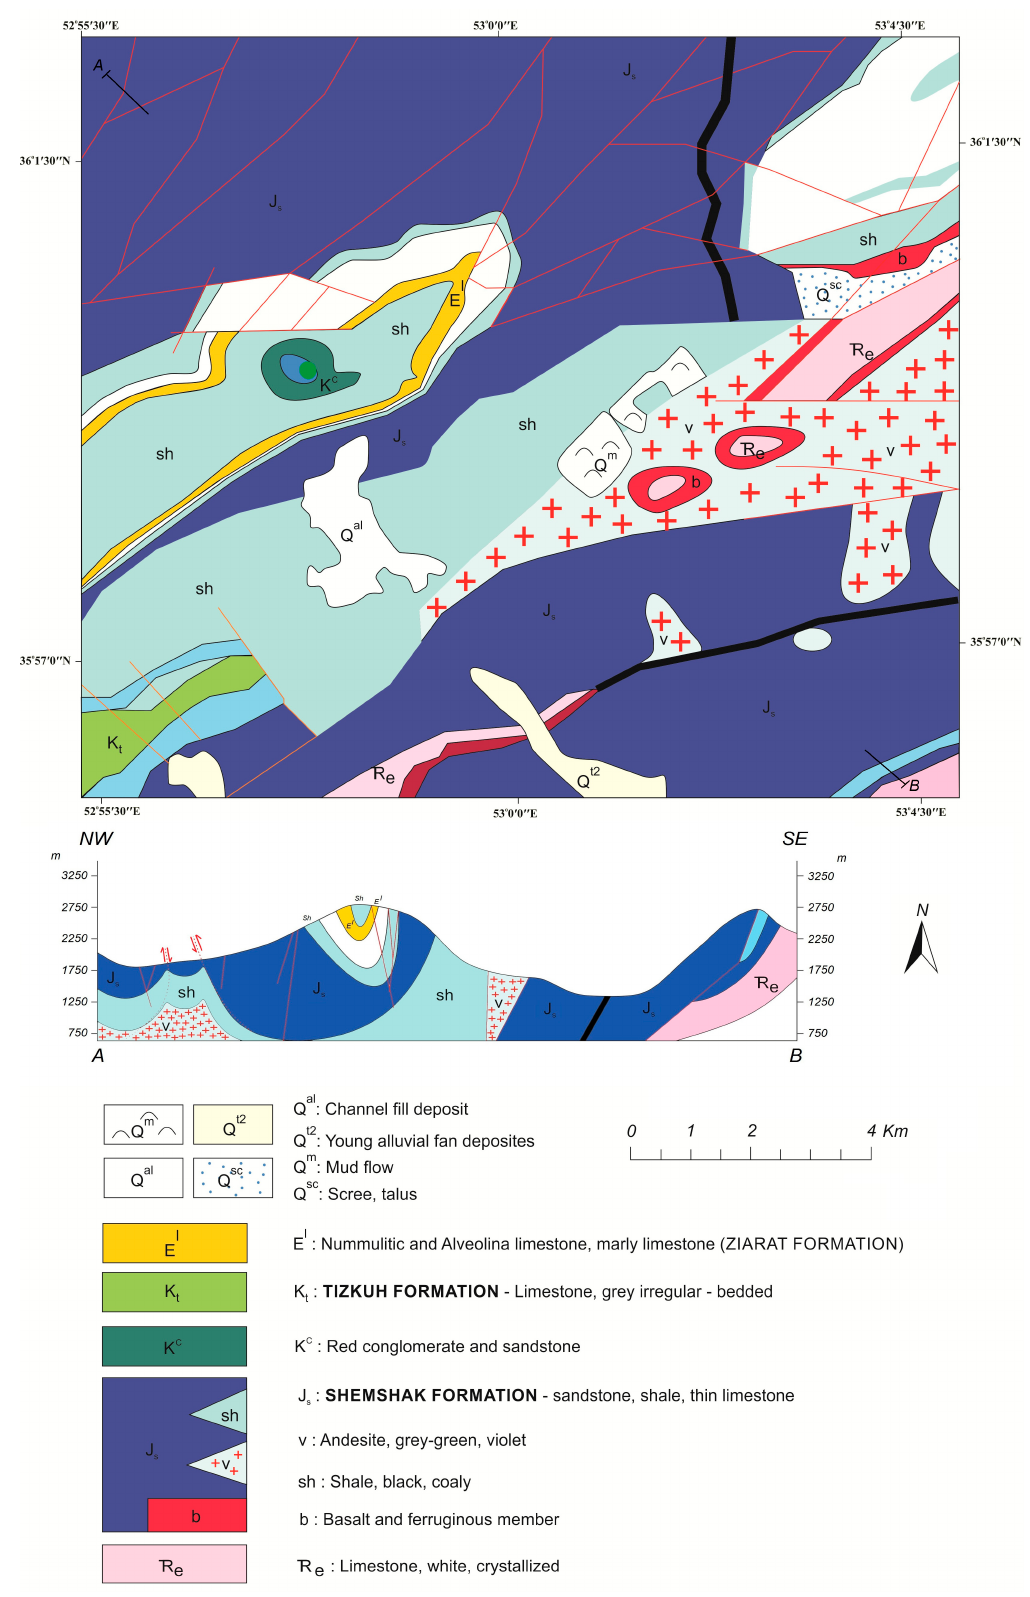
Figure 2. Geological map and cross-section of the Gorzineh-khil region (studied area) [34] .